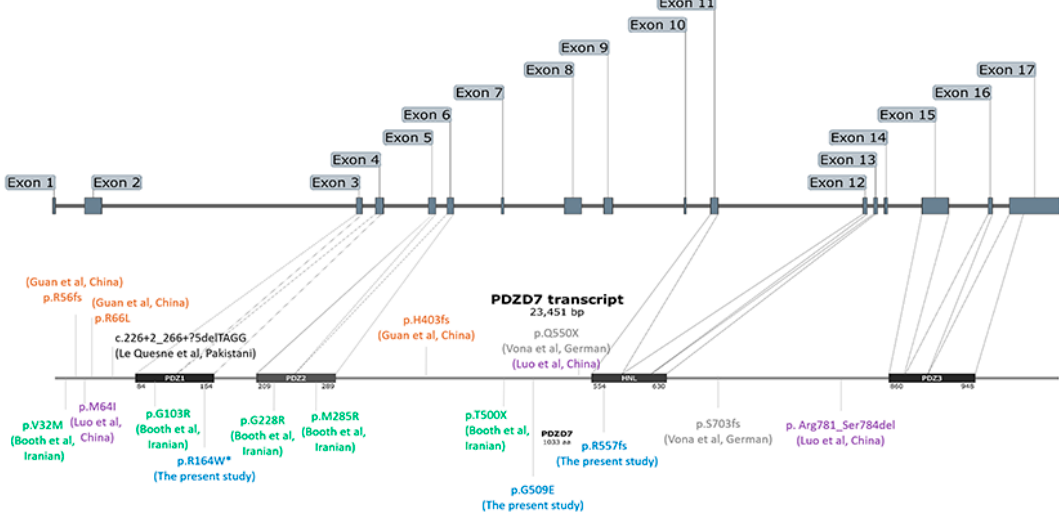
Figure 5. Schematic diagram of the PDZD7 domains map. Previously reported and our novel variants of PDZD7 are presented. The recurring novel missense variant (p.Arg164Trp, asterisk) in the present study resides in the exon 4 encoding PDZ1 domain.